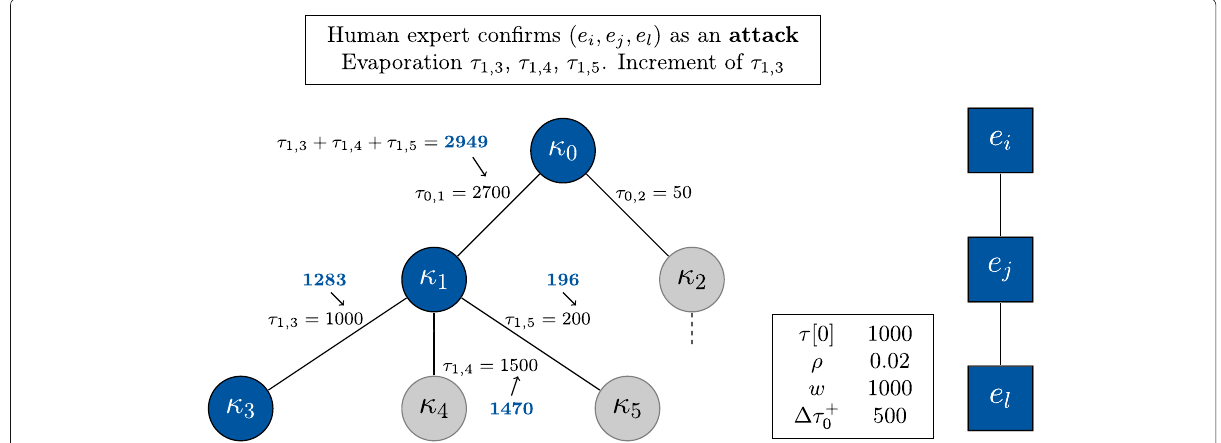
Fig. 8 Example of pheromone evolution if the attack hypothesis is confirmed. Parameters are in Table